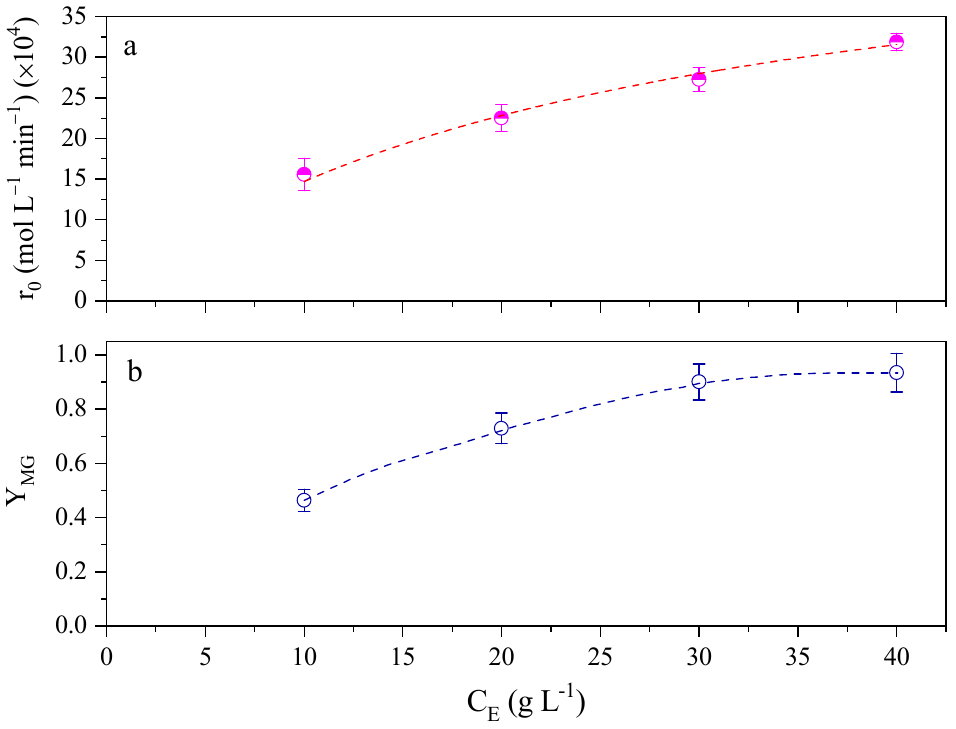
Figure 2. Effect of enzyme concentration on initial rate of esterification of ibuprofen with glycerol using toluene as solvent in the apolar phase at T = 70 ◦ C, C I0 = 60 g · L − 1 , N = 720 rpm over initial reaction rate ( a ) and monoglyceride yield at 24 h ( b ).